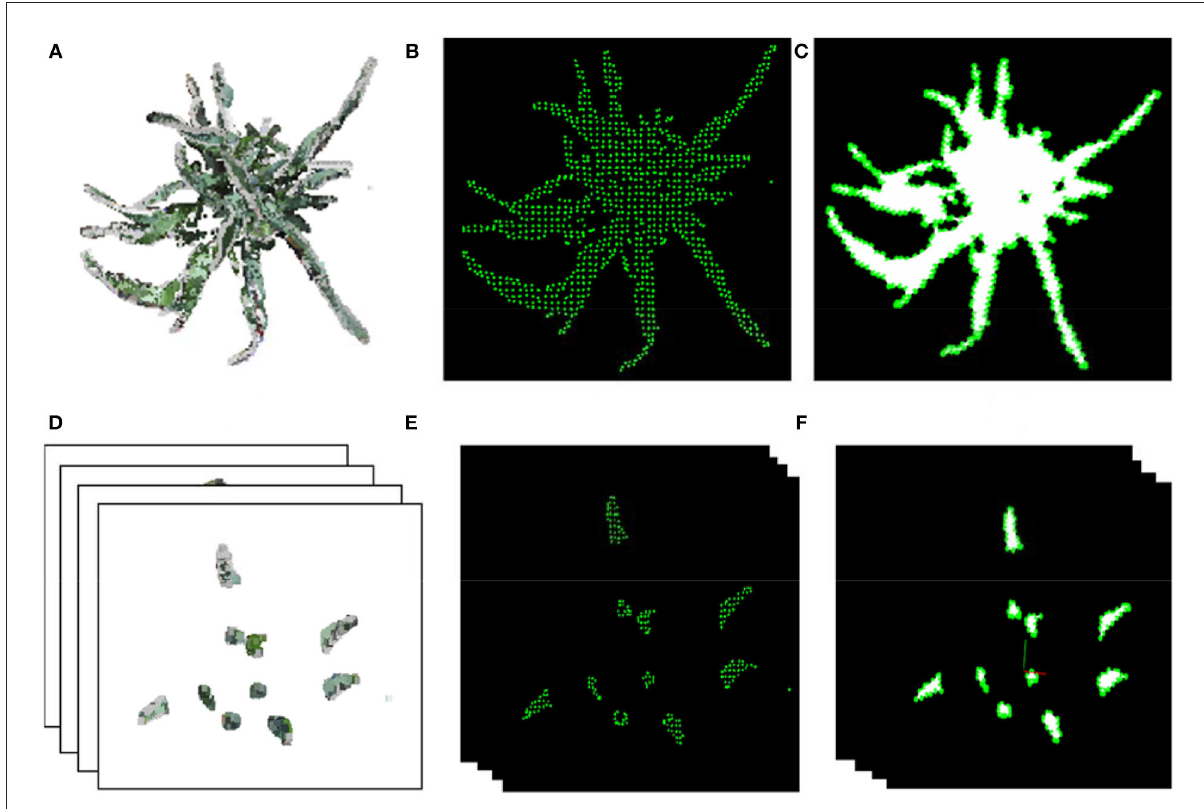
FIGURE5 The projected area and multi-layer projected area. (A,D) Projected point cloud on XOY -plane of a shoot and layers. (B,E) Sparsely sampled points in the XOY -plane of the shoot and corresponding layer in (A,D). (C,F) Generated 2D triangle mesh of points in (B,E) for area estimation.